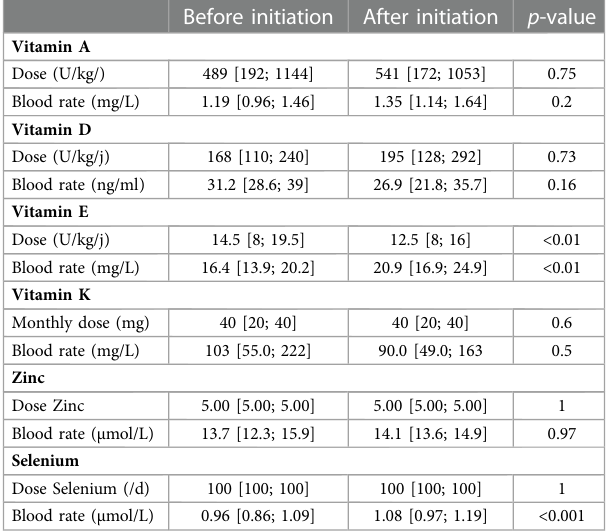
TABLE 4 Changes in supplementation and blood levels of vitamins and micronutrients with lumacaftor/ivacaftor. Before initiation